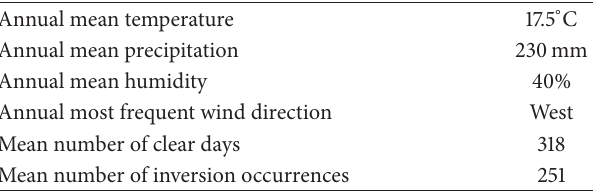
Table 2: An overview on climate data from the station Tehran- Mehrabad (MHR),